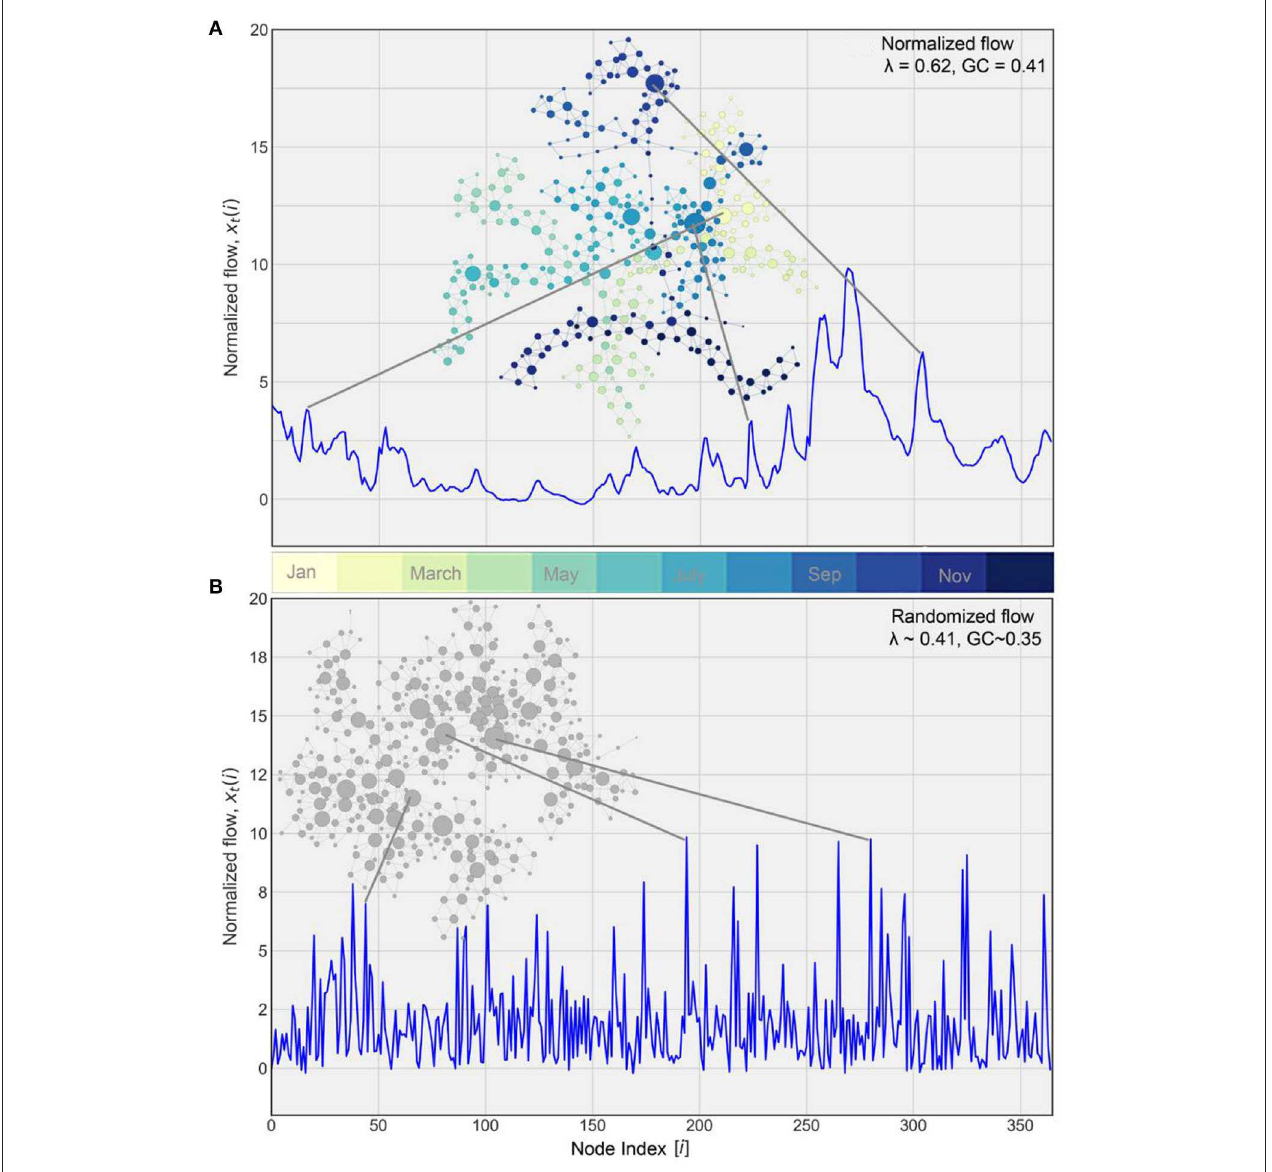
FIGURE 5 | HVG-derived network for the Cedar River at Cedar Rapids for 2016. (A) Network associated with normalized flow (corresponds to Figure 4 ). Each color represents the corresponding month of a year where the size of each node corresponds to the number of connections with its neighbors. (B) Network for randomly shuffled streamflow from (A) . In the normalized data λ > 0.41 indicates the presence of a stochastic process. Both λ and GC are lower in the shuffled time series as